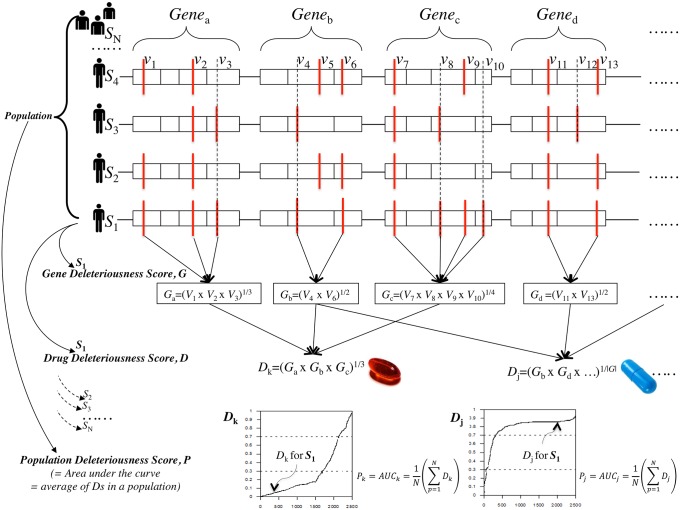
Deleteriousness scores for genes, variants, drugs, and populations.The variant score, (V) is the SIFT score of the variant, the gene deleteriousness score, (G) is the geometric mean of the V scores of the gene, and the drug deleteriousness score (D) is the geometric mean of the G scores for all drug-related PK/PD genes. The drug-gene relationships were obtained from the DrugBank database. The population deleteriousness score (P) or the area under the curve (AUC) for the distribution of the D score for a drug k in a population was computed by averaging personalized D scores of the entire population.